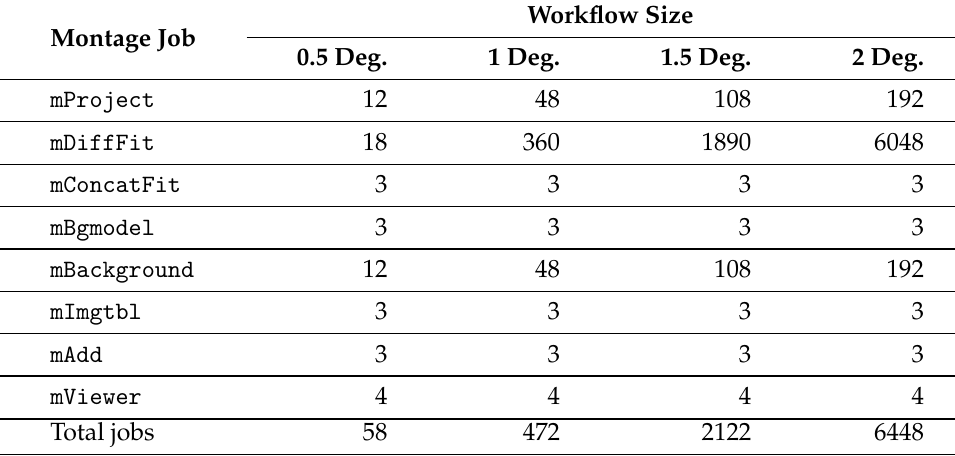
Table 1. Number of each job vs. Montage workflow size. Montage